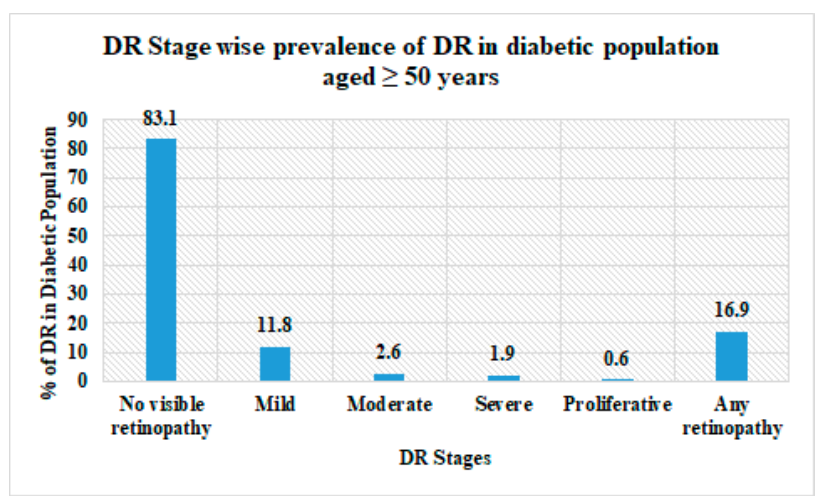
Figure 2. DR stage-wise prevalence of DR in the diabetic population.